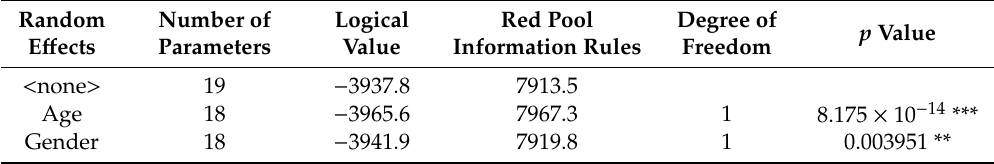
Table 7. ANOVA results for the random e ff ects in the linear mixed